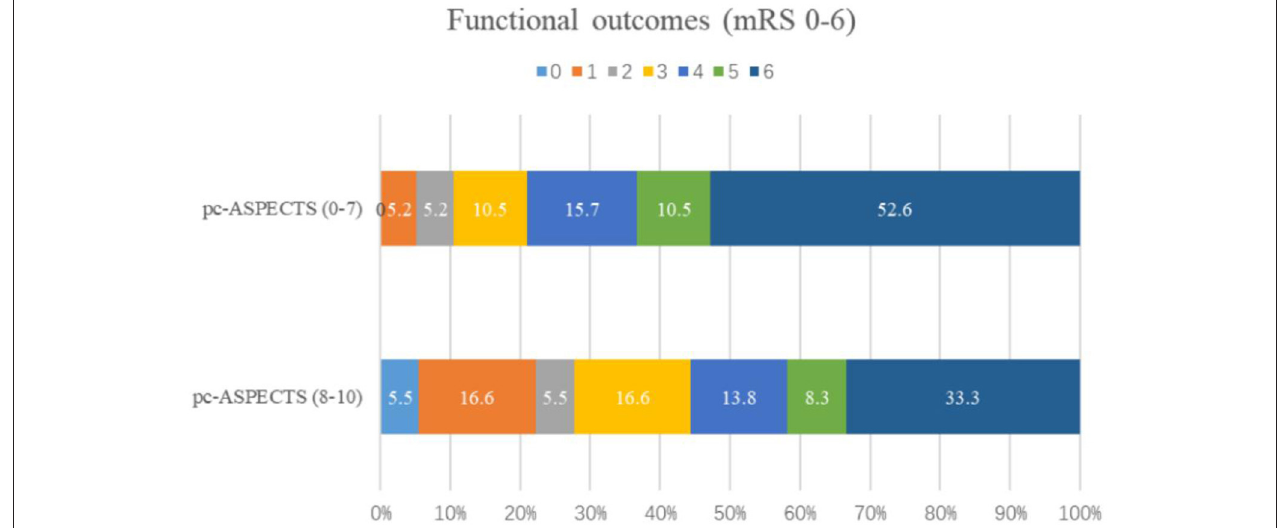
FIGURE 4 | The distribution of the modified Rankin scale (mRS) at 90 days in patients with BAO in two groups. Numbers in bars indicate the percentage of patients. mRS, modified Rankin Scale; pc-ASPECTS, the posterior circulation Acute Stroke Prognosis Early CT